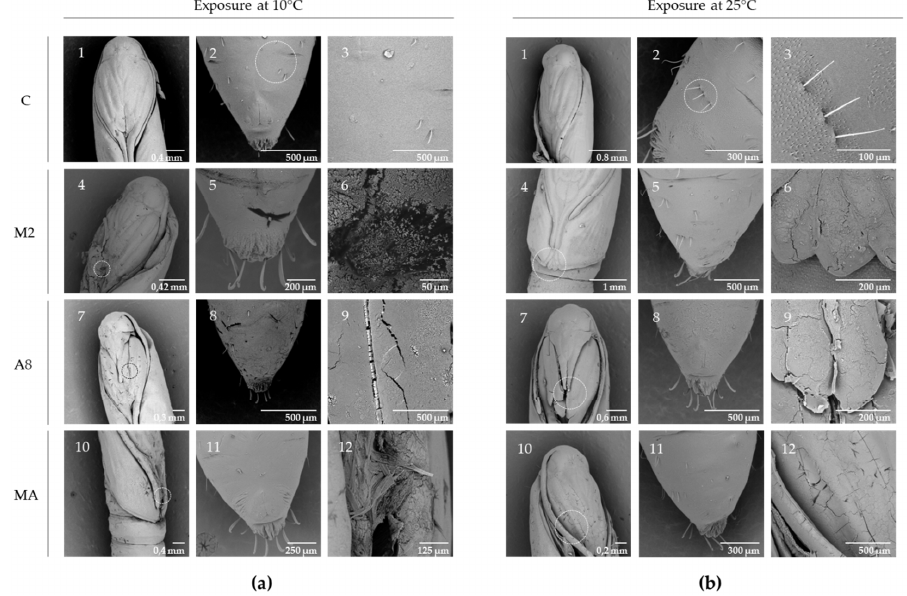
Figure 7. SEM micrographs of individual L. botrana pupae exposed to RGM 2184 protein extract cell supernatant: ( a ) incubated at 10 °C, ( b ) incubated at 25 °C. Row C (1, 2, 3) shows the control treatment; row M2 (4, 5, 6) shows pupae incubated with enzyme extract obtained from RGM 2184 supernatant in M2 culture medium; row A8 (7, 8, 9) shows pupae incubated with enzyme extract obtained from RGM 2184 supernatant in A8 culture medium; row MA (10, 11, 12) shows pupae incubated in a mixture of enzyme extracts from RGM 2184 supernatant grown in M2 and A8 culture media (images in the third column of each panel).